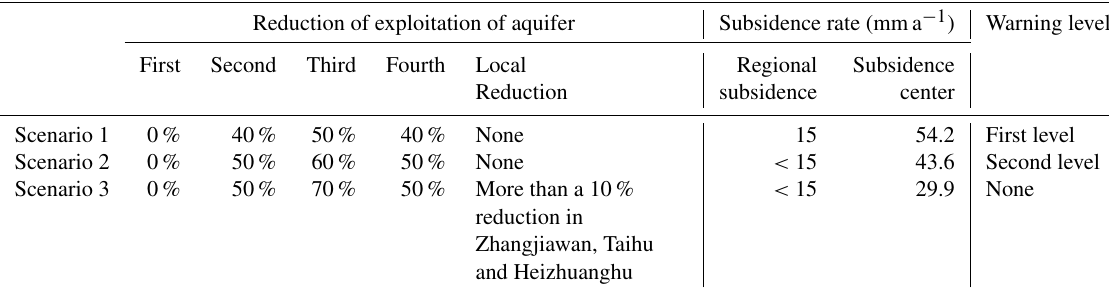
Table 2. The different reduction scenarios of groundwater